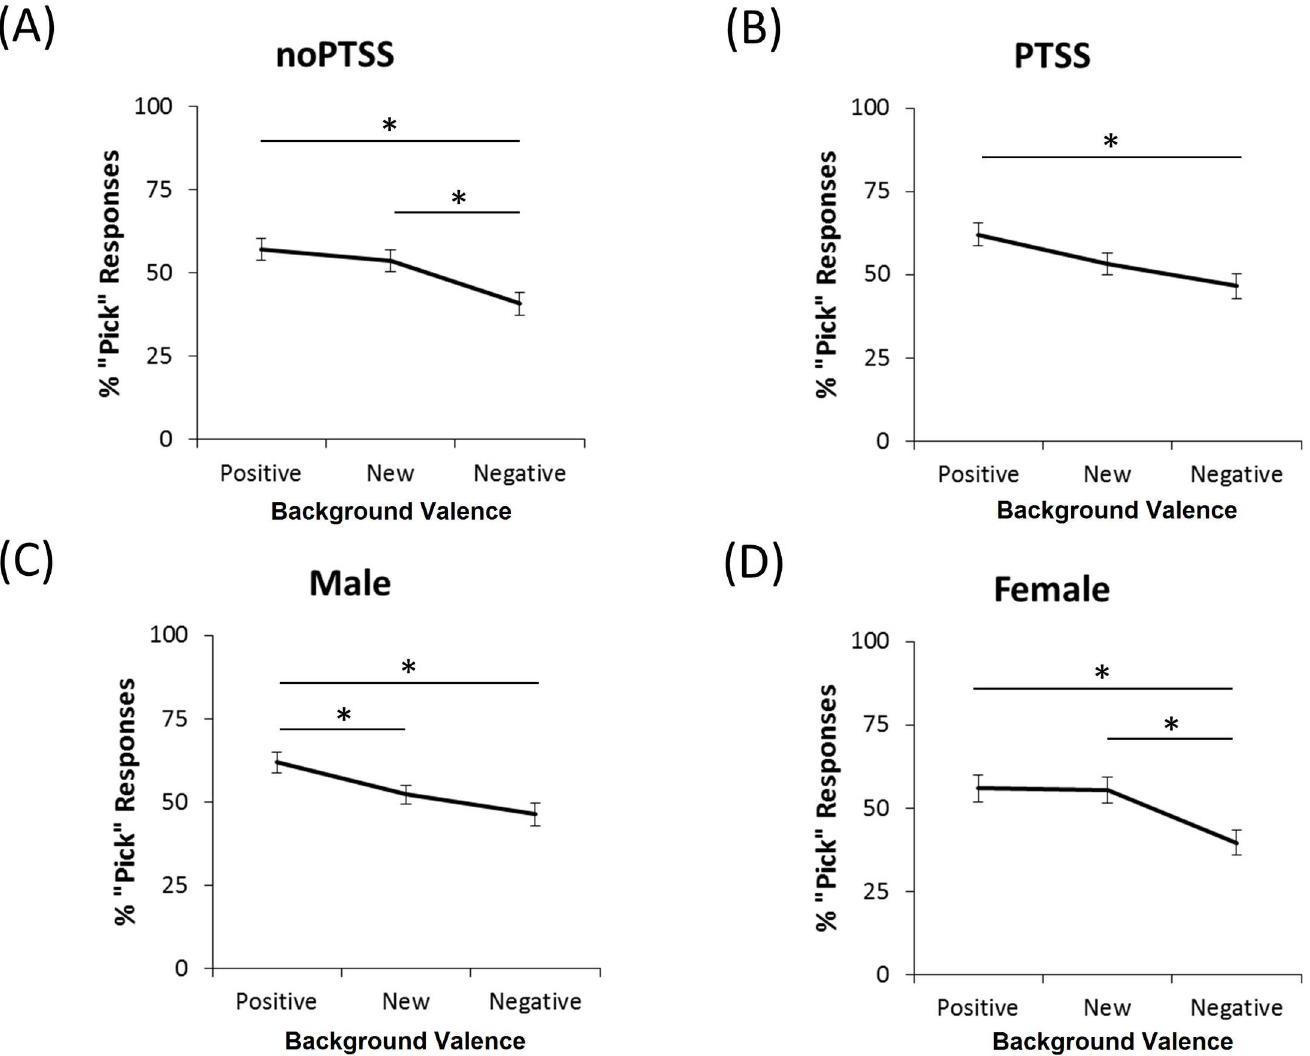
Fig 6. Percent “pick” responses as a function of PTSS and gender. (A) Generally,“pick” responseswere made on about 50% of trials with a new background. However, participants in the noPTSS group tendedto treat positive and new backgrounds as similar, and make fewer “pick” responses on trials with a negative background. (B) For participantsin the PTSS group, only the difference betweenpositive and negativebackgroundsreached significance. (C) While males tendedto make more “pick” responses for positive backgrounds, comparedto either new or negativebackgrounds, (D) females did not distinguishpositive from new backgrounds. Instead, they made more “pick” responses to new comparedto negative backgrounds. Similar to males, they also made more “pick” responses for positive than negativebackgrounds. Asterisks indicate significantwithin-subject